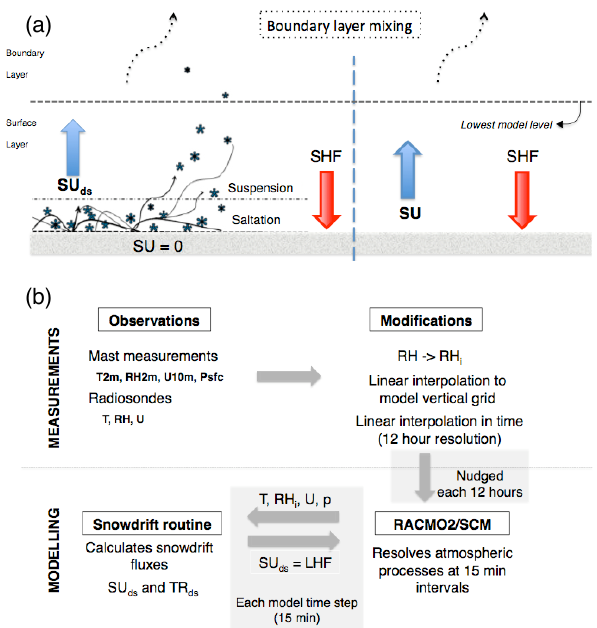
Fig. 2. (a) Schematic illustration of the snowdrift sublimation pro- cess in RACMO2/SCM. The left side represents the situation when snowdrift is activated, the right side when snowdrift is not active. The horizontal dashed line marks the boundary between the sur- face layer and the boundary layer in the model, which is the lowest model level (7m). (b) Flow chart of the methods and tools used in this